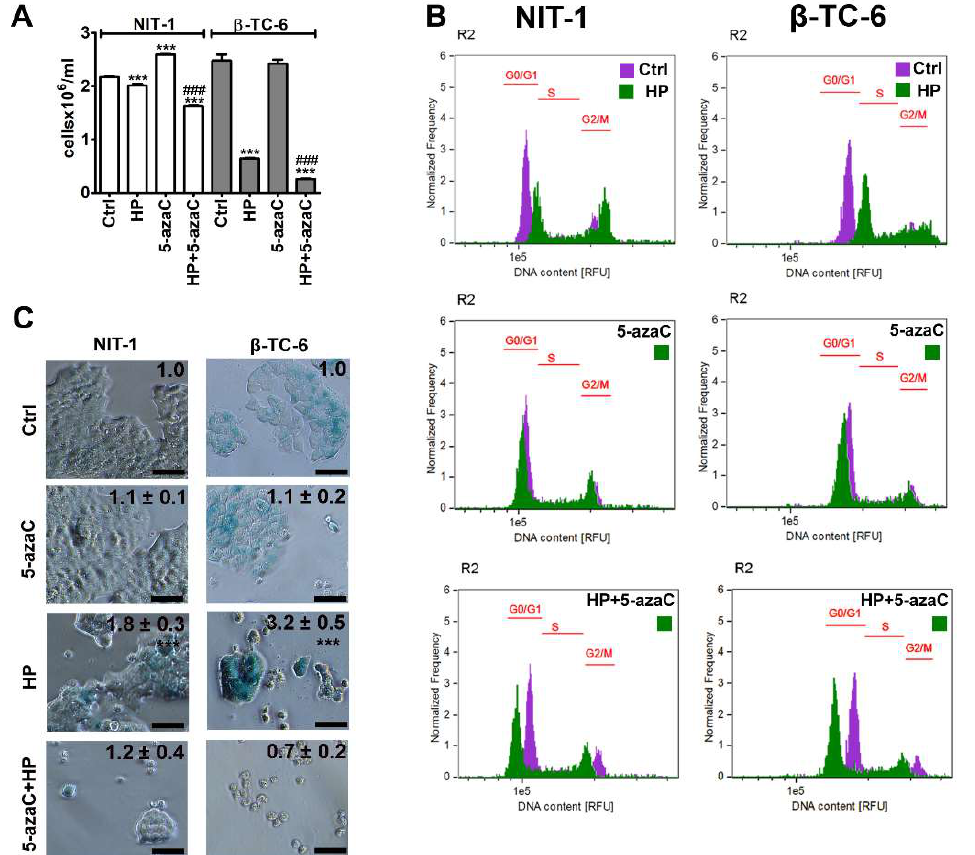
Figure 1. 5-AzaC post-treatment-mediated changes in cell number ( A ), cell cycle ( B ) and senescence- associated β -galactosidase (SA- β -gal) activity ( C ) in hydrogen peroxide-treated mouse insulinoma NIT-1 and β -TC-6 cells. Insulinoma cells were stimulated with 100 µ M HP for 24 h and then post- treated with 1 µ M 5-azaC for 24 h. ( A ) Cell number was calculated automatically using dedicated cell counter. Bars indicate SD, n = 3, *** p < 0.001 compared to Ctrl (ANOVA and Dunnett’s a posteriori test), ### p < 0.001 compared to HP-treated cells (ANOVA and Tukey’s a posteriori test). ( B ) DNA content-based analysis of cell cycle was conducted using imaging flow cytometry. Representative histograms are shown. Violet, untreated samples; green, treated samples. The phases of cell cycle (G0/G1, S and G2/M) are denoted using red horizontal lines. ( C ) SA- β -gal activity was assayed after 7 days of 5-azaC removal using dedicated biochemical test. Representative microphotographs are shown. Objective 20 × . Quantitative analysis of the intensity of SA-beta-gal-positive signals (blue signals) is also provided. SA-beta-gal-positive signals at untreated conditions were considered as 1.0 for each cell line and treated samples were normalized to corresponding control samples, n = 3, *** p < 0.001 compared to Ctrl (ANOVA and Dunnett’s a posteriori test). Ctrl, control conditions; HP, hydrogen peroxide (H 2 O 2 ) treatment; 5-azaC, azacytidine treatment; HP+5-azaC, hydrogen peroxide treatment, and azacytidine